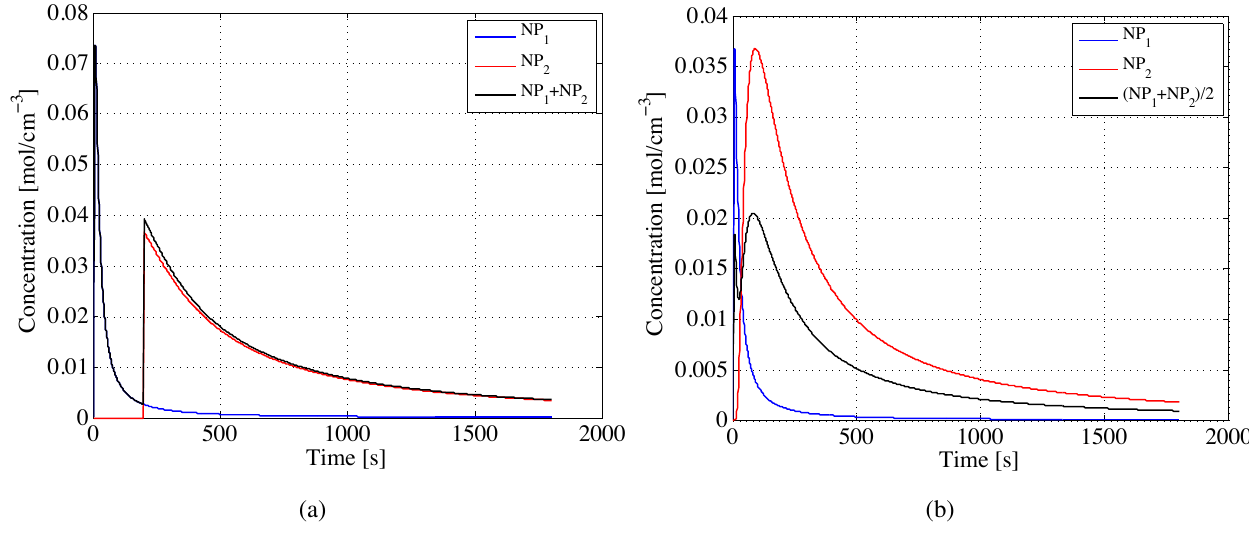
Figure 5. Nanoparticle concentrations for two flows NP asynchronous and ( b ) synchronous mode. The resulting concentrations are depicted in